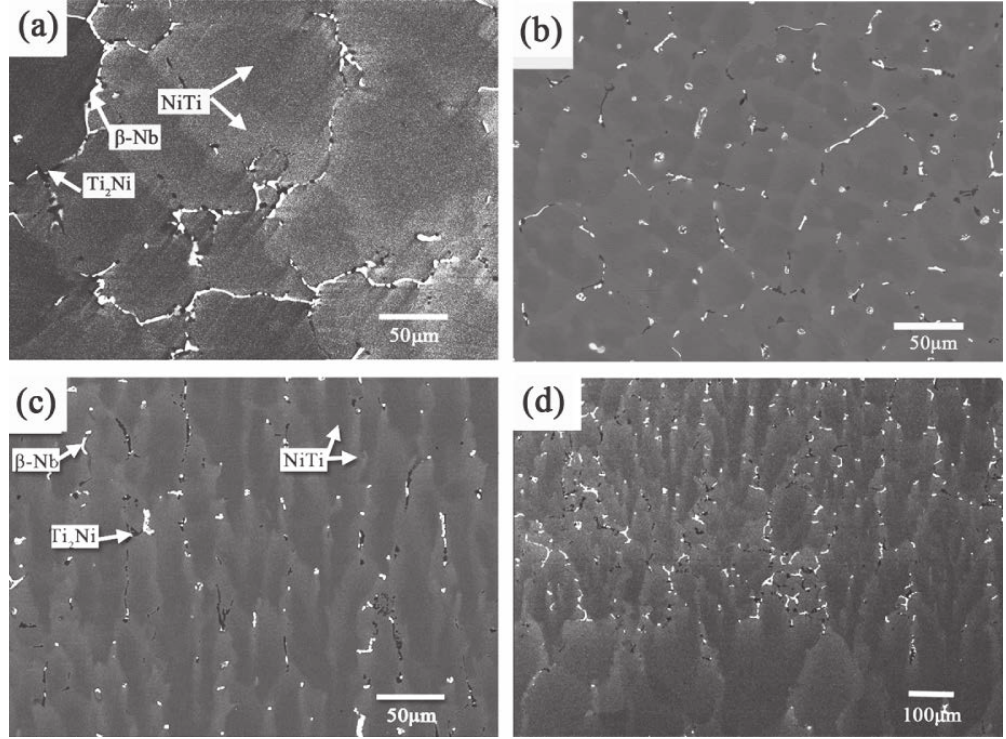
Fig. 2: EPMA micrographs of the as-cast and the DS alloys obtained at 1550°C using Y 2 O 3 /Al 2 O 3 crucibles: (a) as-cast; (b) transverse section of the DS steady-state region; (c) longitudinal section of the DS steady-state region; (d) DS initial transition region.